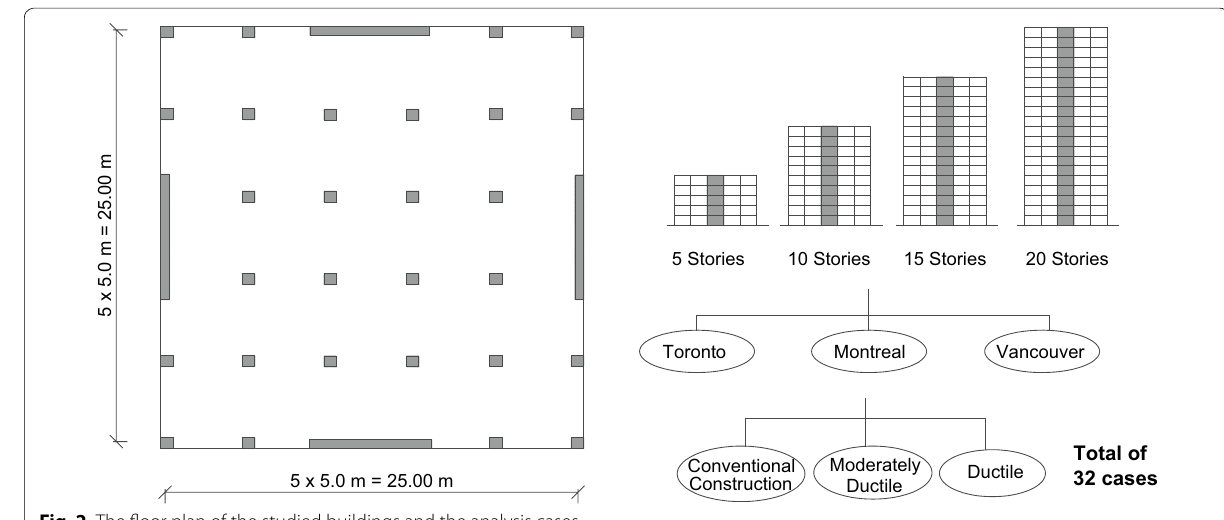
Fig. 2 The floor plan of the studied buildings and the analysis